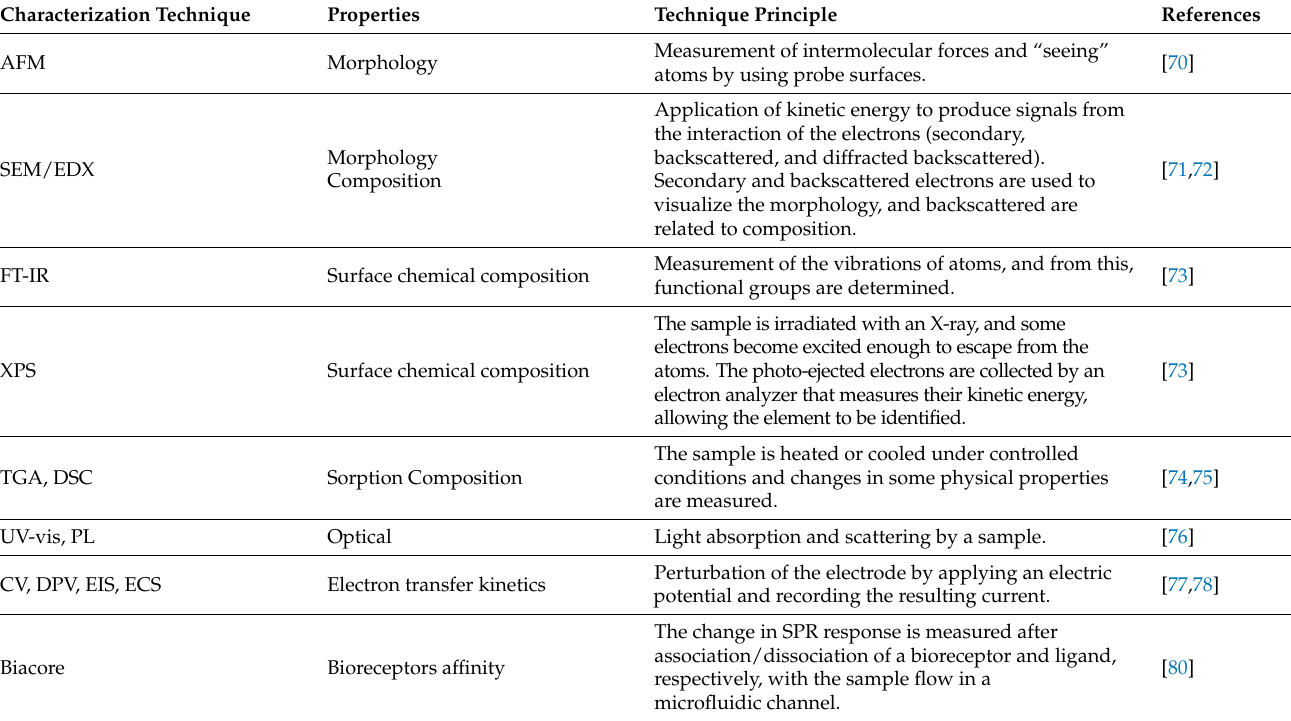
Table 2. Characterization techniques of electrochemical